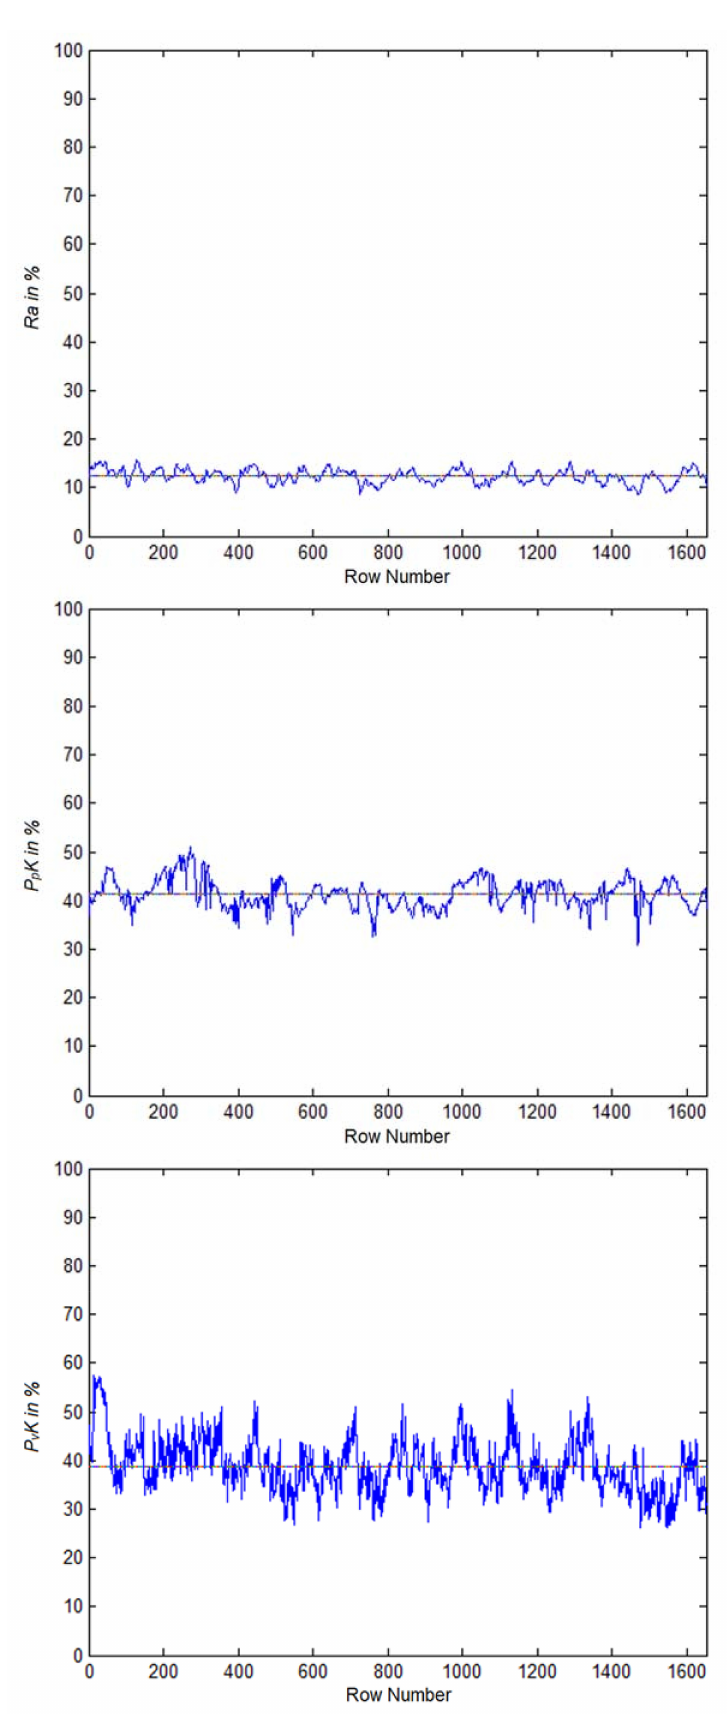
Figure 10. Optical roughness metrics versus ROI row number for the example image shown in Figure